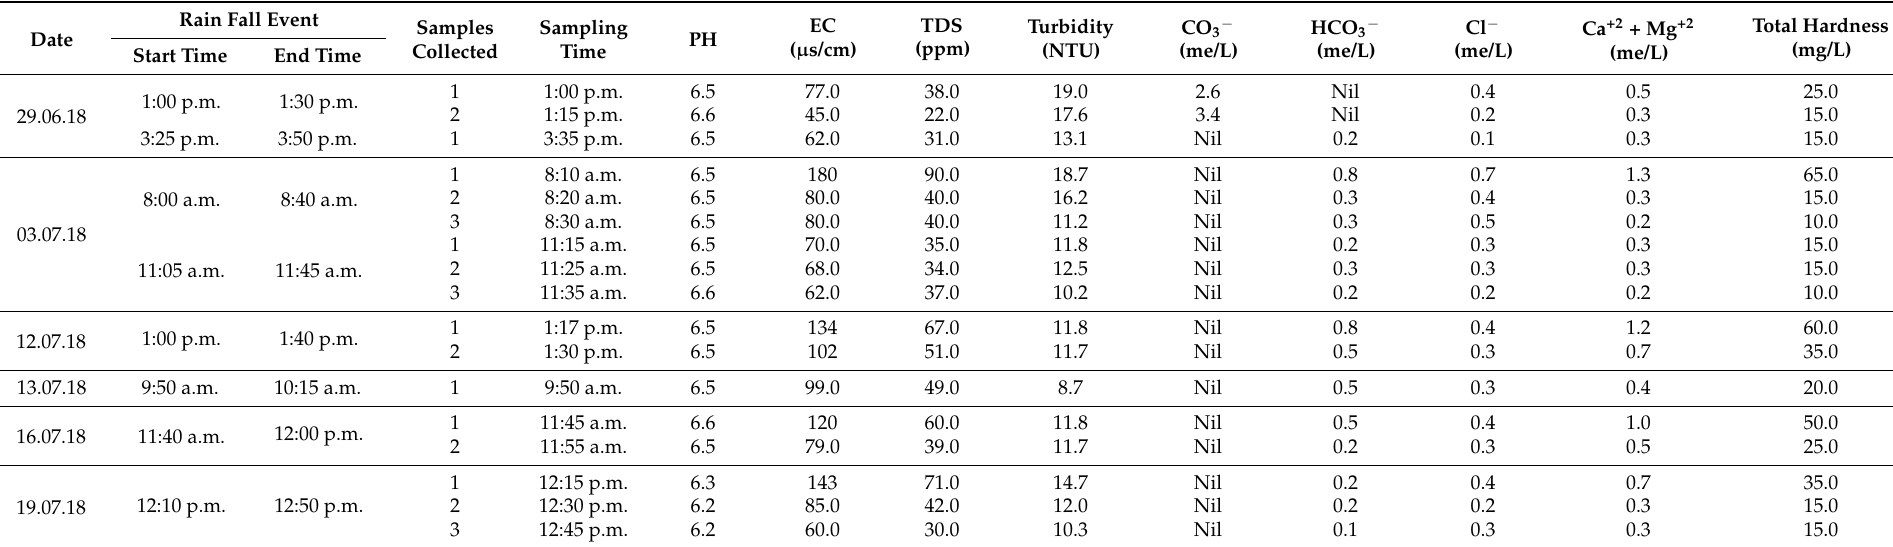
Table A3. Direct rain samples collected from Site 1.